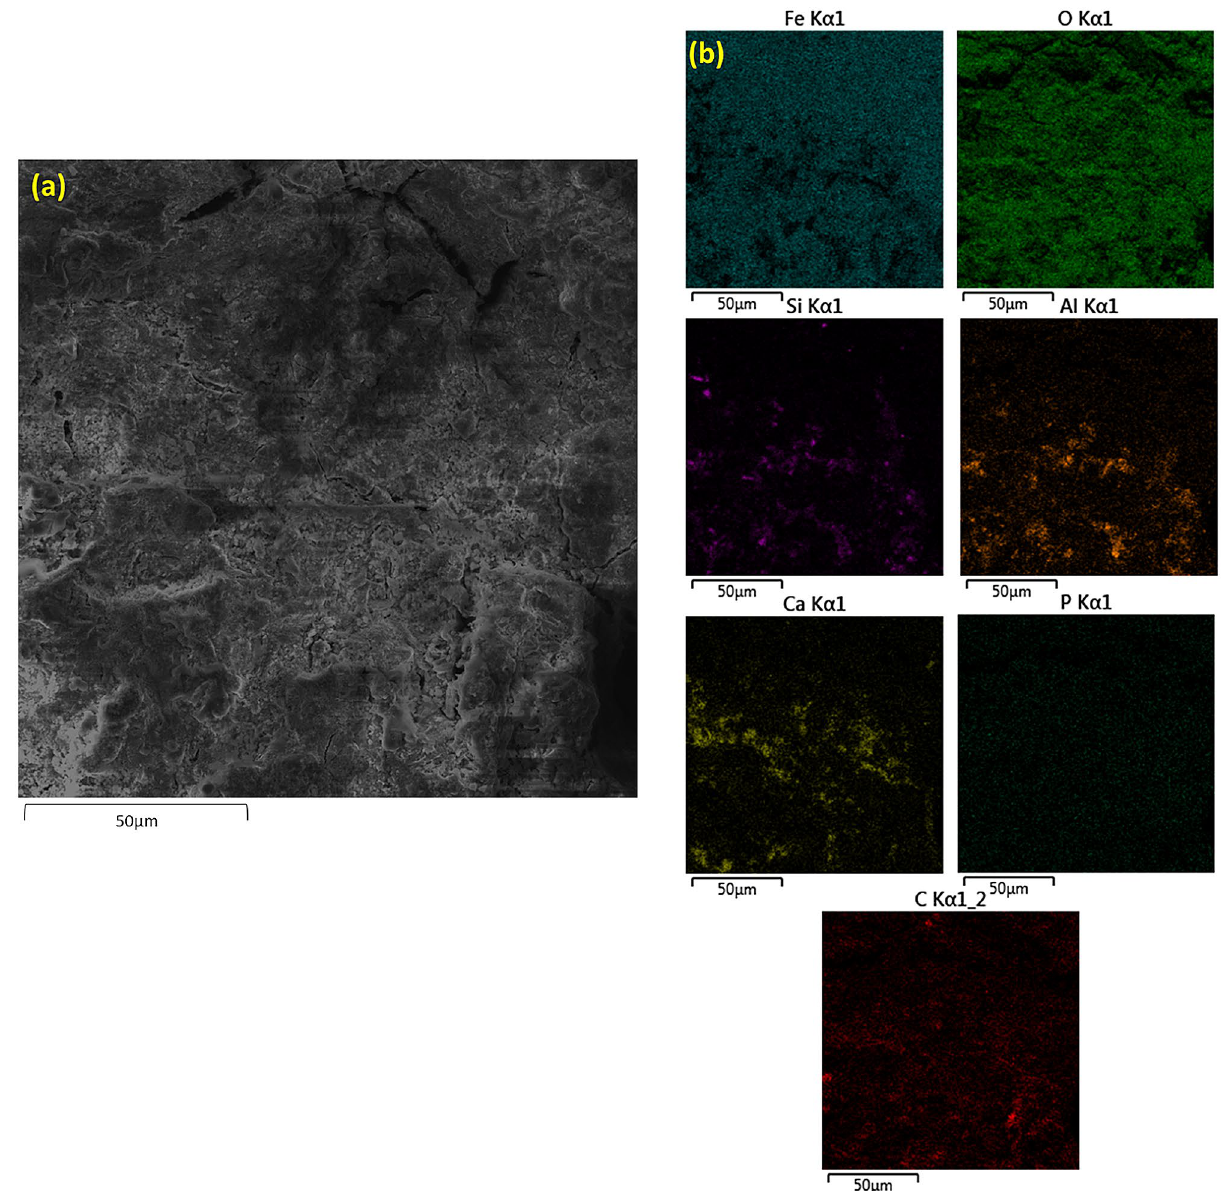
Figure 5. ( a ) FESEM images of corrosion product film formed on the surface of iron made through ancient Indian metallurgical methods exhibits ( b ) EDS mapping of Fe, O, Si, P (dot points indicate the instrument noise), Ca, Al and,